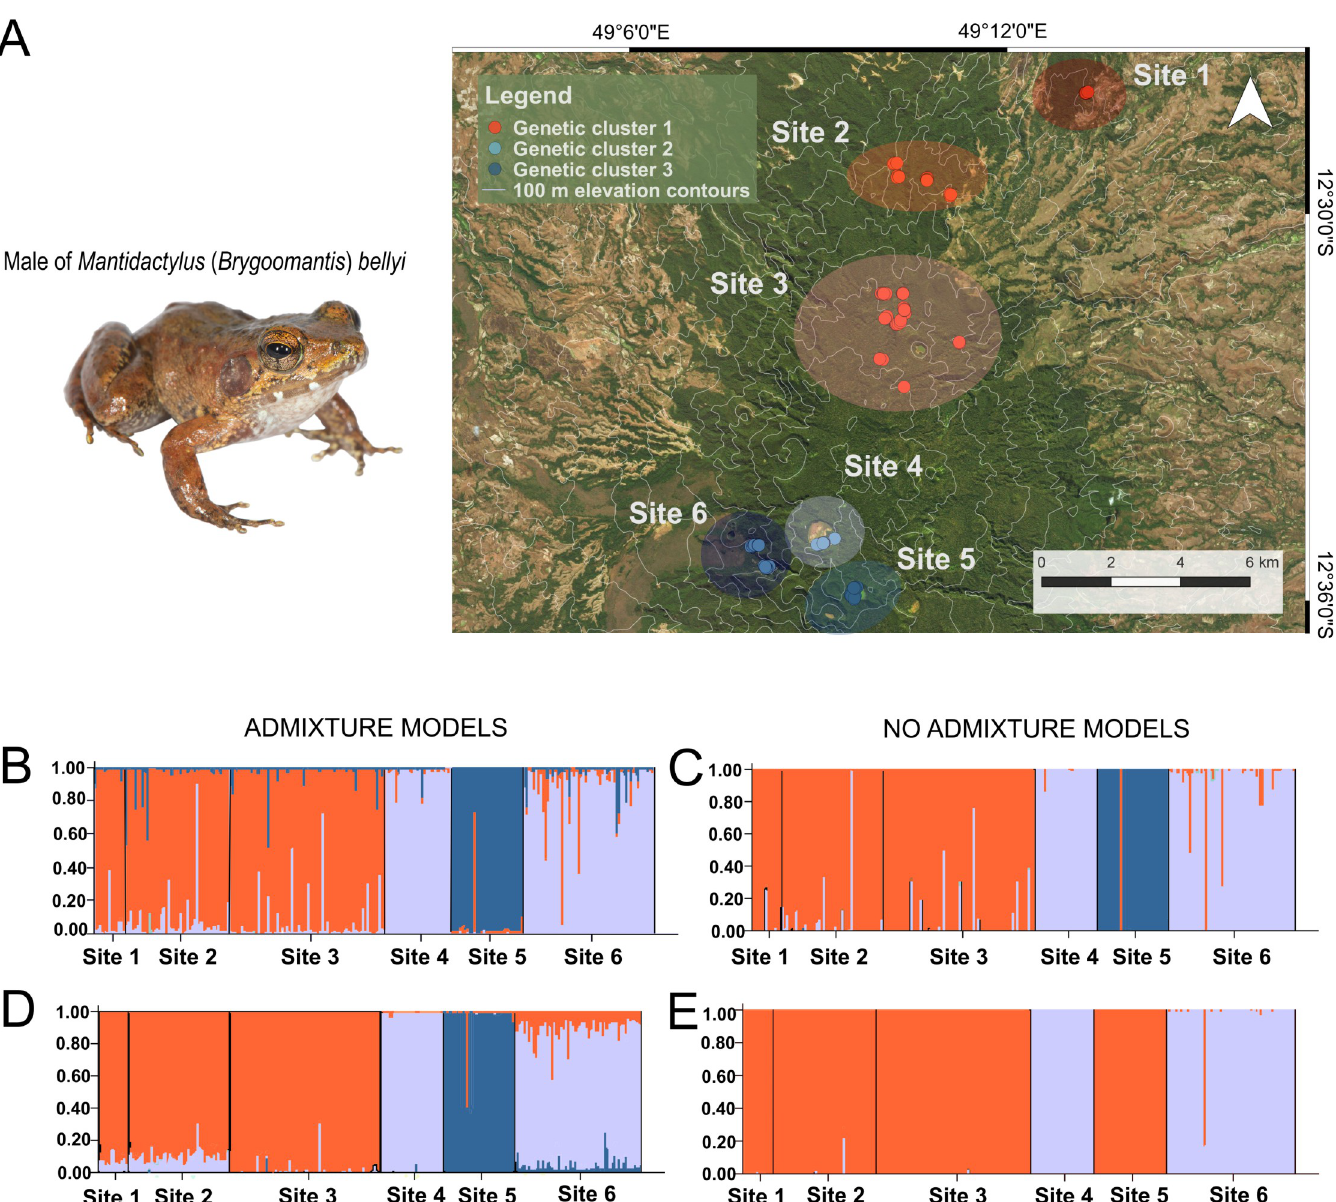
Fig 2. Sampled populations of Mantidactylus bellyi and their genetic cluster assignment. A] A male specimen of Mantidactylus bellyi and a map of Montagne d’Ambre, showing the a priori grouping into six sites based on geographical proximity as emphasized by large circles. Each dot represents a specimen of M . bellyi collected at a specific locality. The dots were colored according to the assignment of the individual to a genetic subpopulation cluster as in the K = 3 STRUCTURE models. B–E] Individual assignments of 236 individuals of M . bellyi to genetic clusters as inferred by STRUCTURE from a data set of seven microsatellites. The clustering scenarios of subpopulations K = 2–3 were depicted for the B] Admixture model (K = 3), C] No admixture model (K = 3), D] Admixture model with LOCPRIOR information (K = 3) and E] No admixture model with LOCPRIOR information (K = 2). Satellite imagery of the park were taken from Microsoft 1 Bing ™ Maps.